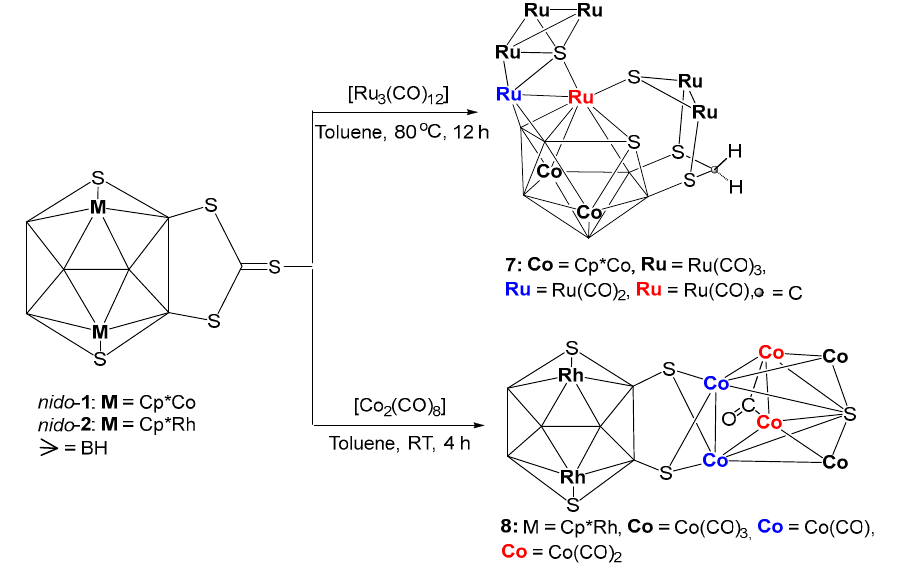
Figure 3. Comparison of frontier molecular orbitals of 3 , 4 , 5 and 6 ; respectively. Contour values for isosurface are ±0.04 (e/bohr 3 ) 1/2 .